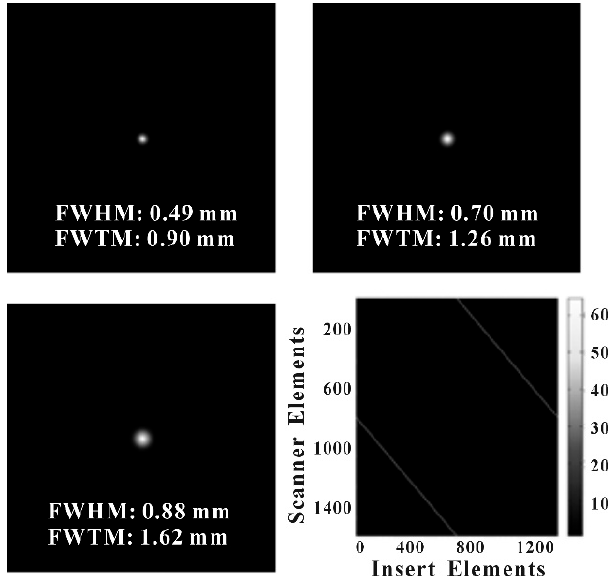
Figure 5. Reconstructed PET images of an 18 F point source with a diameter of 0.5 mm for the insert– insert (II), insert-scanner (IS) and scanner-scanner (SS) coincidence events (from top to bottom). The gamma-ray detection matrix of the IS coincidence events is also shown in the bottom right of the figure.